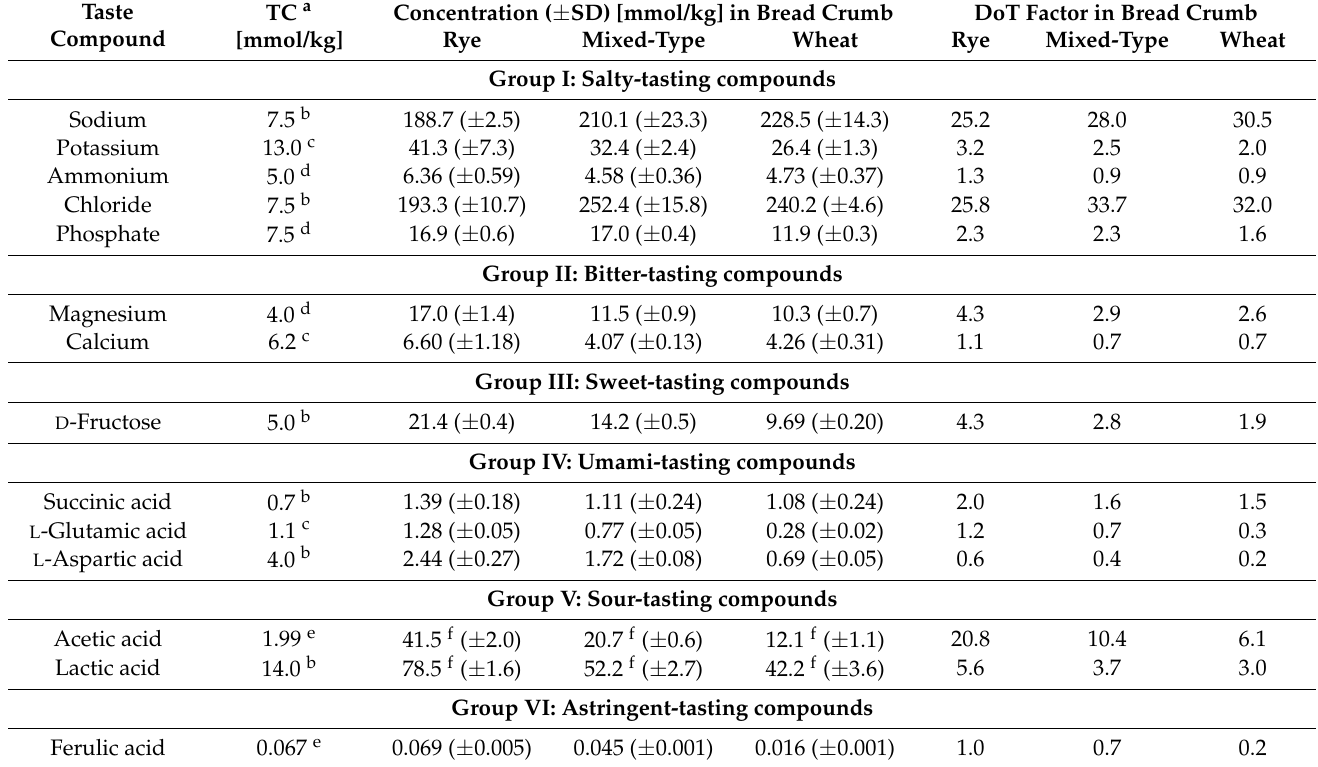
Table 2. Taste qualities, taste thresholds, concentrations, and dose-over-threshold (DoT) factors of the basic tastants in the crumb of sourdough rye bread, mixed-type bread, and wheat